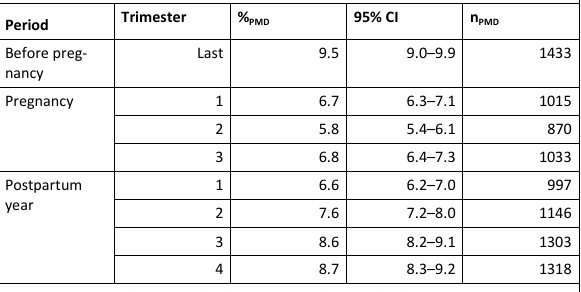
Table 2: Three-month prevalence rates of the use of mental health care. Period